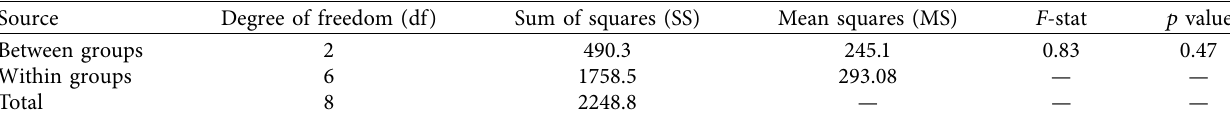
Table 8: ANOVA table of SOC stock between soil layers for lower mixed hardwood forest.